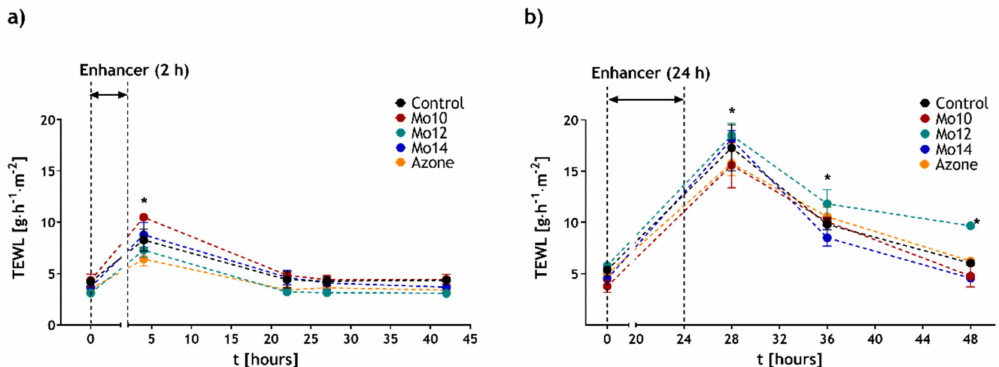
Figure 3. The reversibility of enhancers- effects on skin TEWL when applied for 2 h ( a ) and 48 h ( b ). Mean ± SEM, n ≥ 5; * Statistically significant difference compared to the respective control (pure